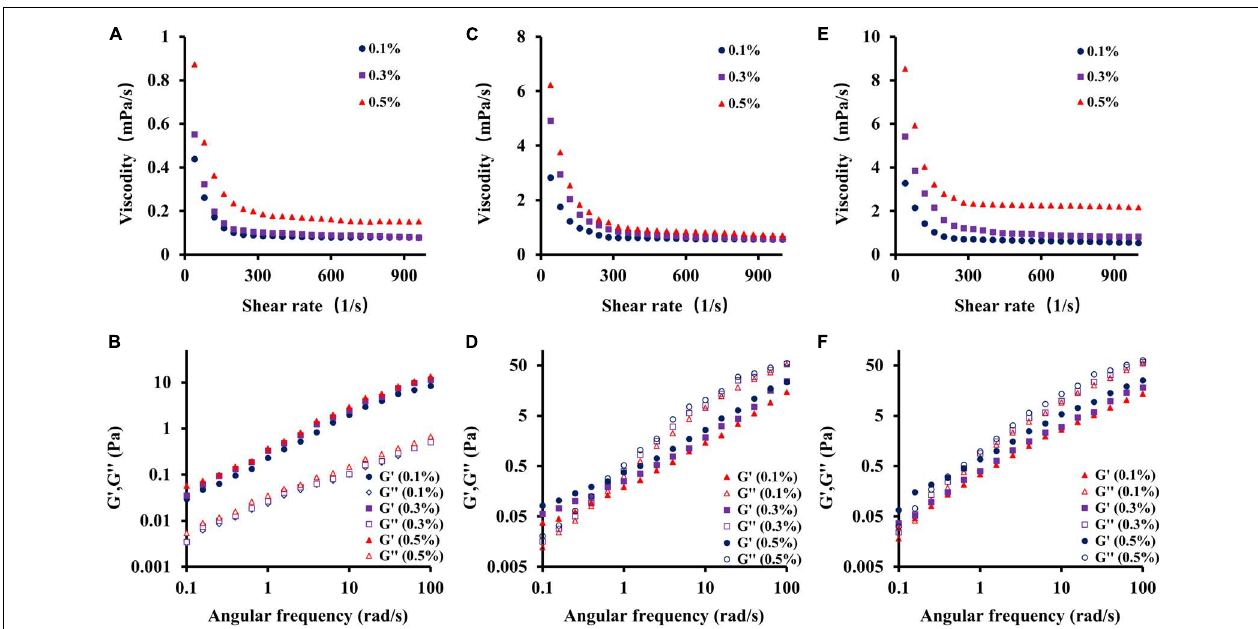
FIGURE 5 | Dependence of apparent viscosity on the shear rate and plots of storage modulus G’ and loss modulus G” against frequency for CSFP, CSFP1- β , and CSFP2- α . (A,B) Rheological characteristic diagram of CSFP, (C,D) Rheological characteristic diagram of CSFP1- β , and (E,F) Rheological characteristic diagram of CSFP2- α